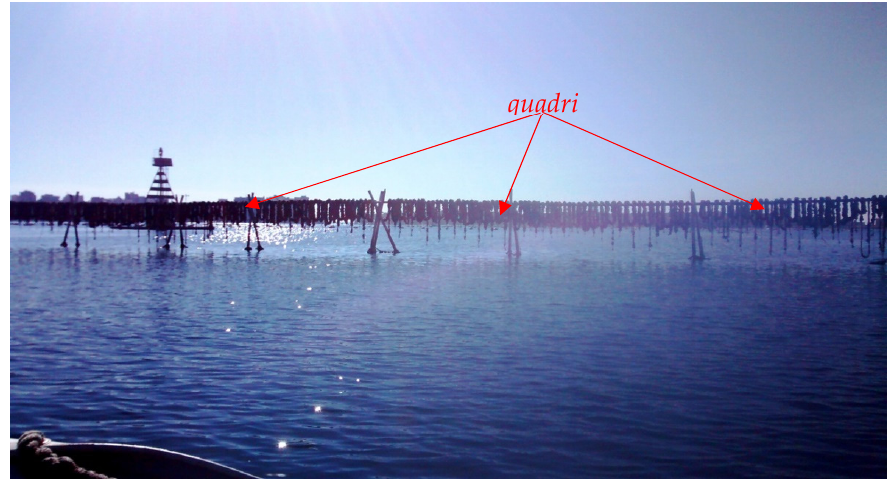
Figure 2. Traditional mussel farms called “quadri” in the first inlet of Mar Piccolo (Puglia Region). May 2015.